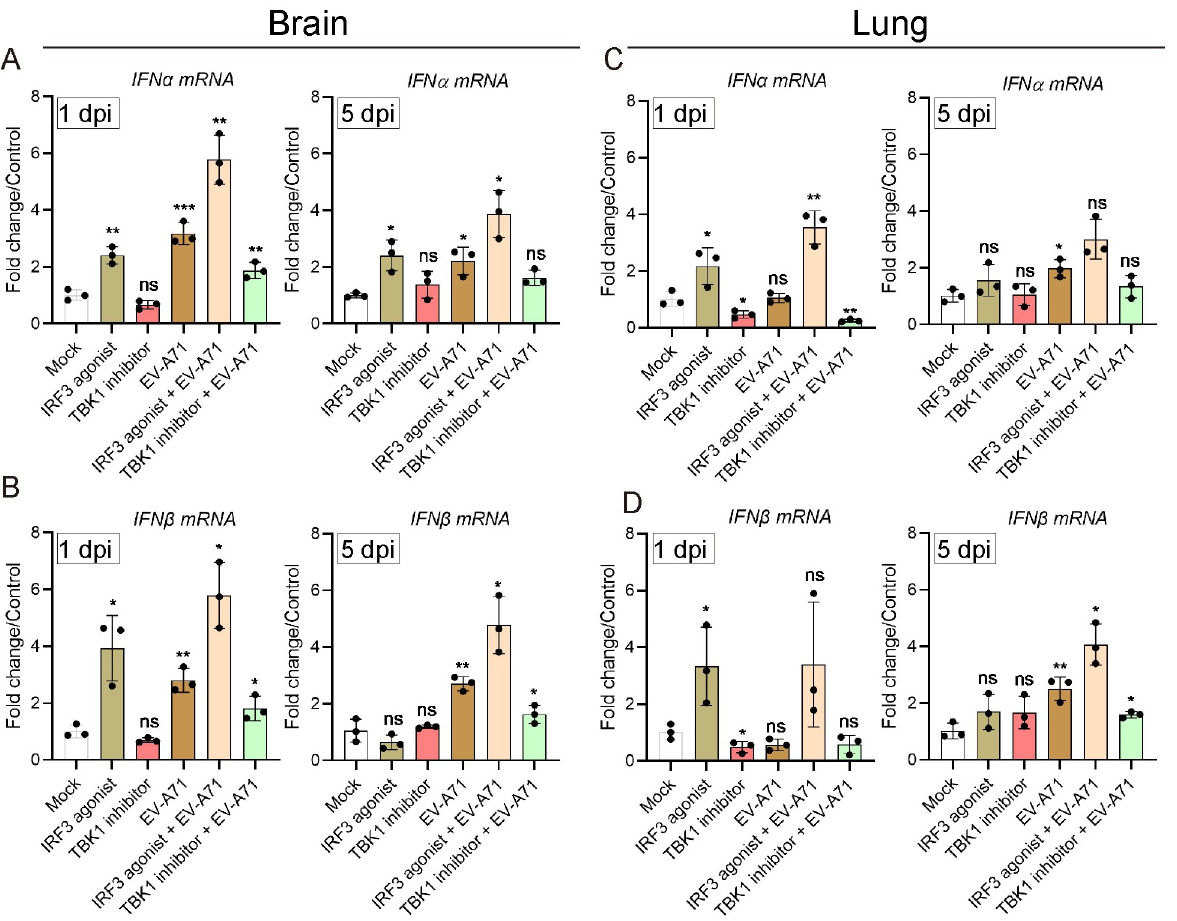
Fig 2. TBK1 and IRF3 interventions on type I IFN response in the brains and lungs of EV-A71-infected mice. qPCR was conducted to measure the expression levels of IFN- α and IFN- β in the brains ( A and B ) and lungs ( C and D ) of EV-A71-infected mice or mock mice with TBK1 and IRF3 interventions at 1 and 5 dpi. Results were normalized by β -actin. Data represent mean ± SD. n = 3 per group; TBK1 and IRF3 interventions alone, EV-A71 vs Mock; TBK1 and IRF3 interventions mice with EV-A71 infection vs EV-A71-infected mice; � P < 0.05; �� P < 0.01; ��� P < 0.001; ns, no significant. All the experiments were repeated at least three